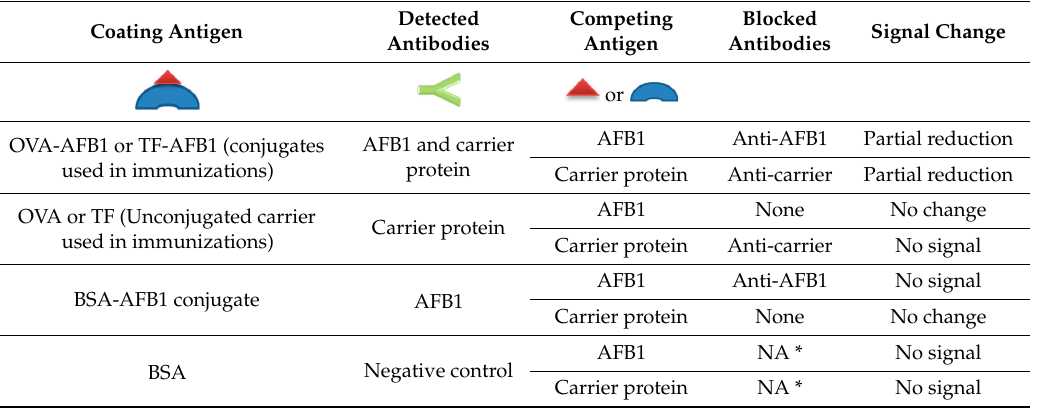
Table 1. Interpretation of IC-ELISA results.